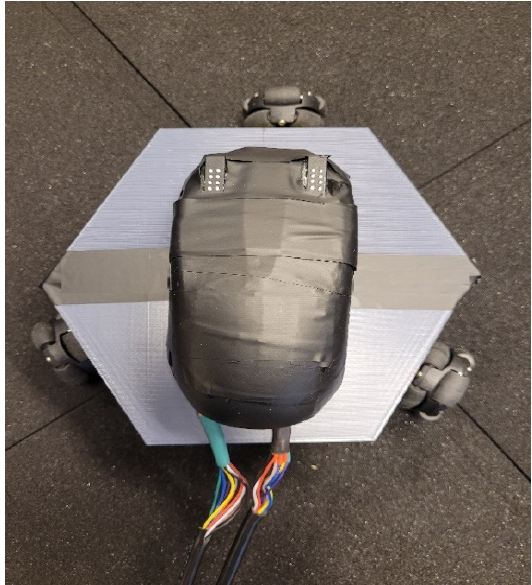
Figure 2. System current prototype.